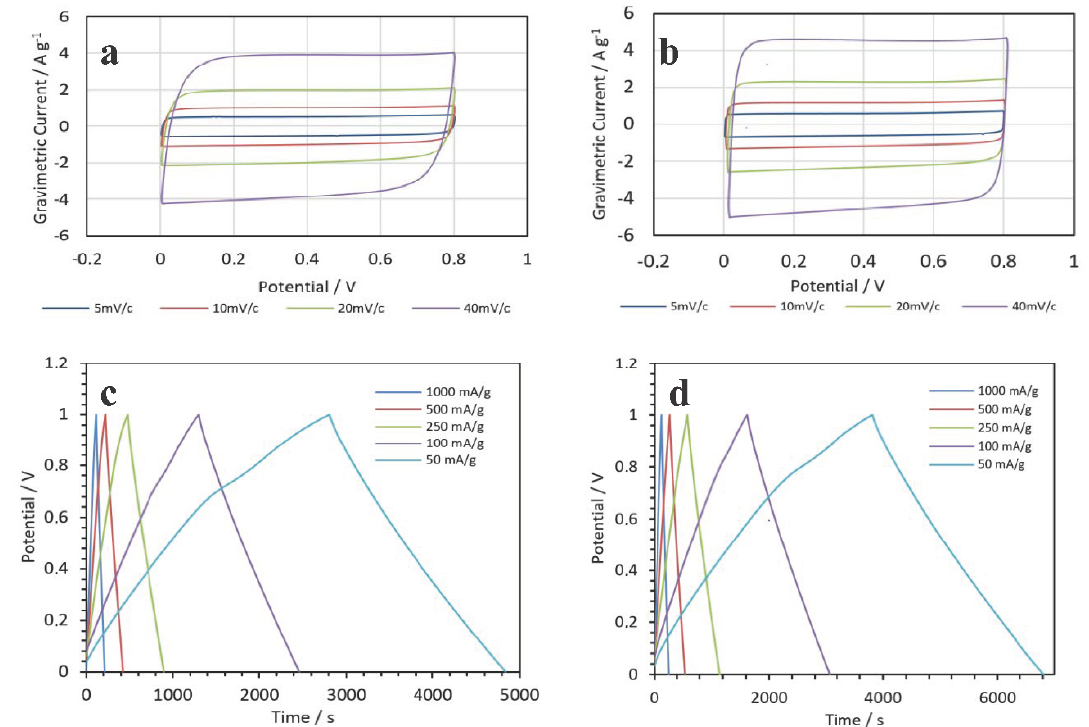
Figure 4. ( a ) CV of pure ARH electrodes. ( b ) CV of electrodes from ARH with 9 wt.% Ni(OH) 2 . ( c ) GCD of electrodes from pure ARH. ( d ) GCD of electrodes from ARH with 9 wt.% Ni(OH) 2 . Di ff erent Ni(OH) 2 contents have been tested and the resulting capacitance, obtained from